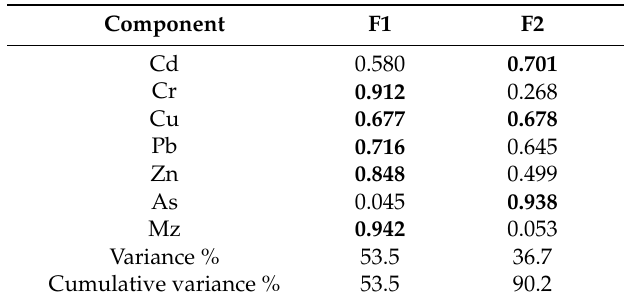
Table 5. Rotated component matrix for principal component analysis loadings for heavy metals contents and mean grain size [24] in the surface sediment from the study